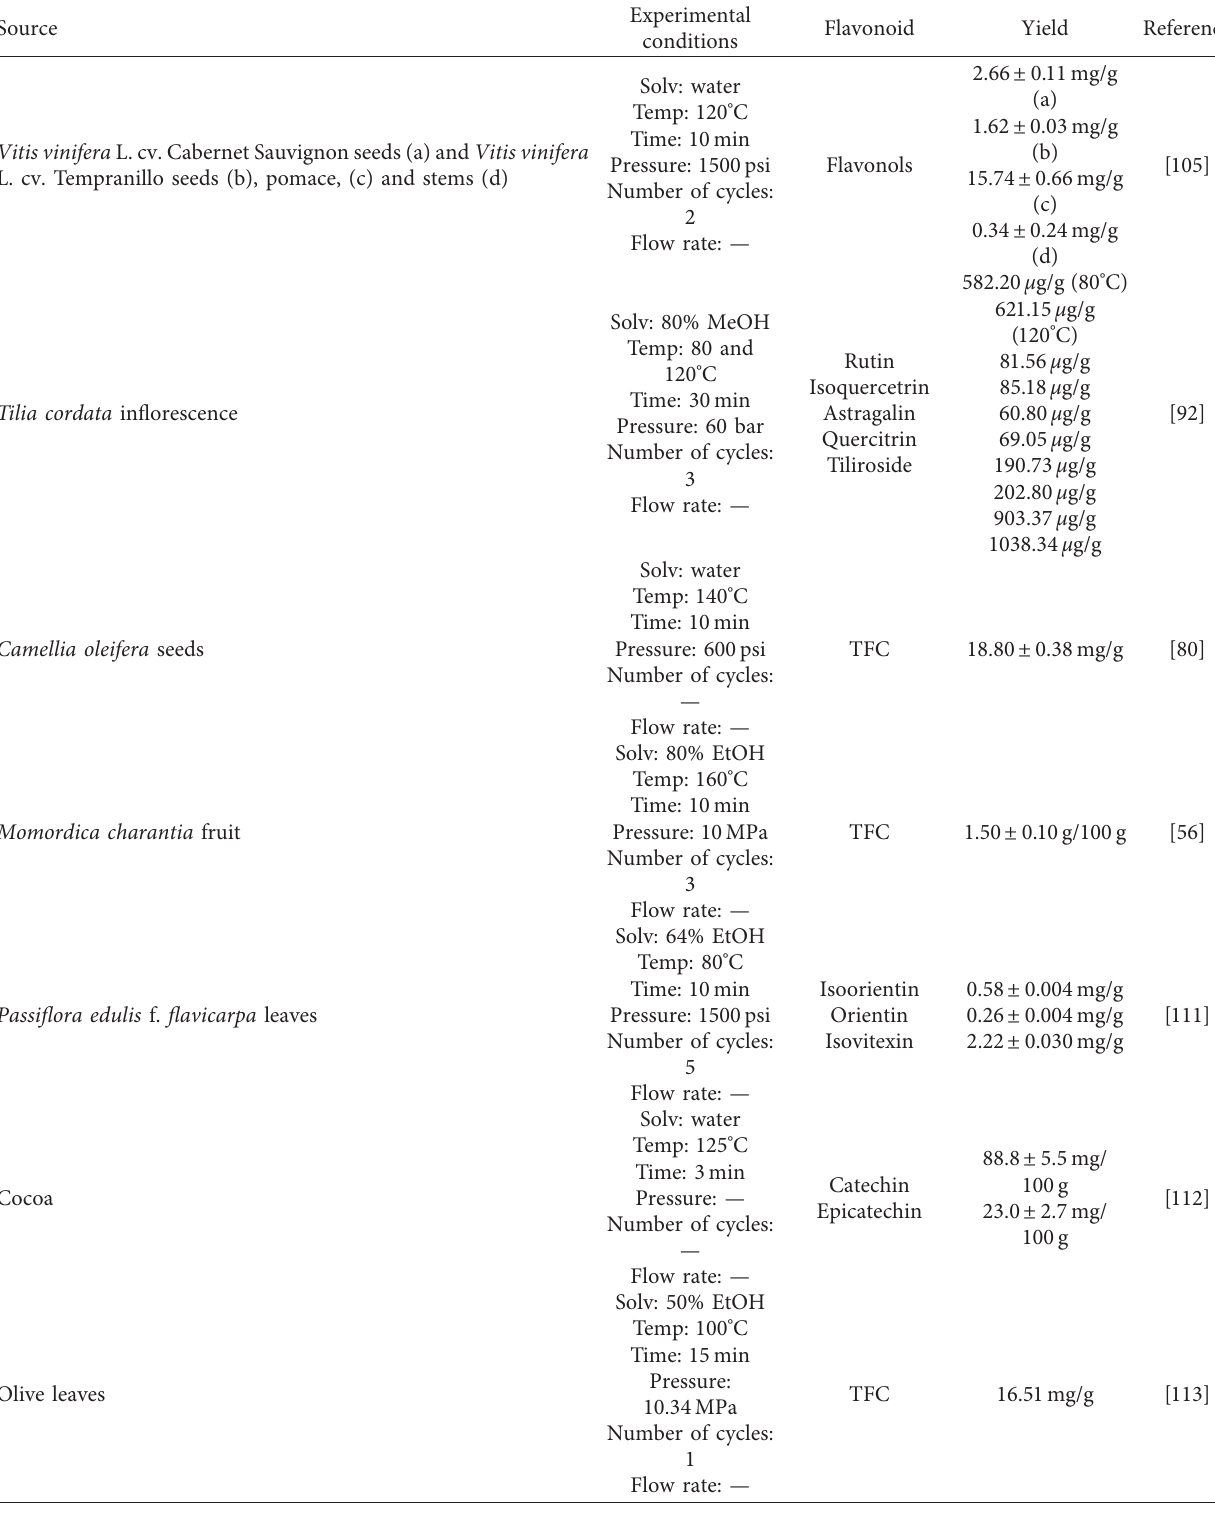
Table 3: PLE of flavonoids (general conditions of